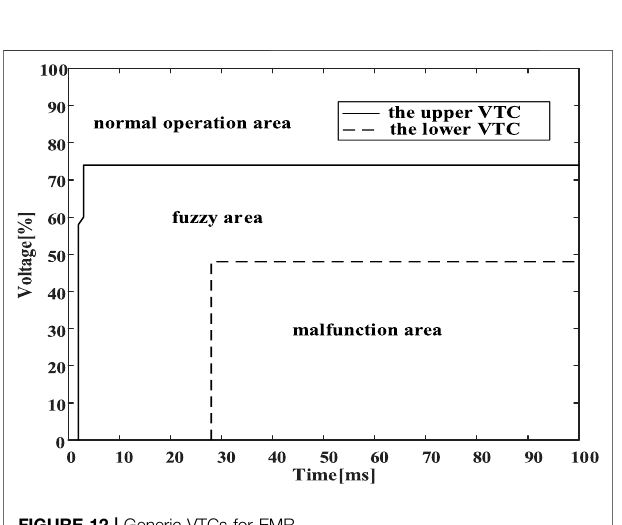
FIGURE 12 | Generic VTCs for EMR.